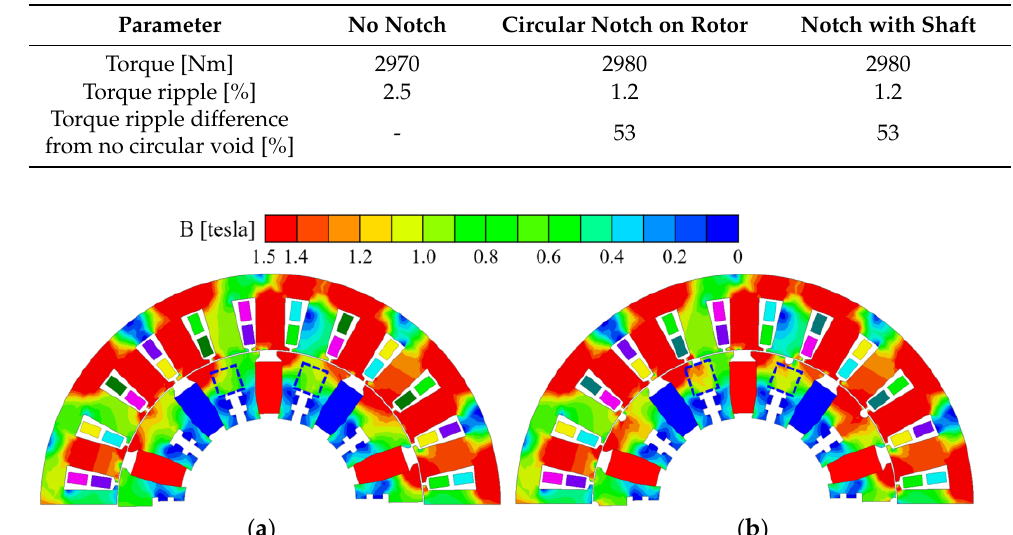
Figure 10. Design of 6Φ -SS-FSCW-Fer-SIPMSM ( a ) without and ( b ) with circular notch on the rotor and rectangular nonmagnetic shaft fixture. Table 4. Performance comparison between conventional and proposed motor.